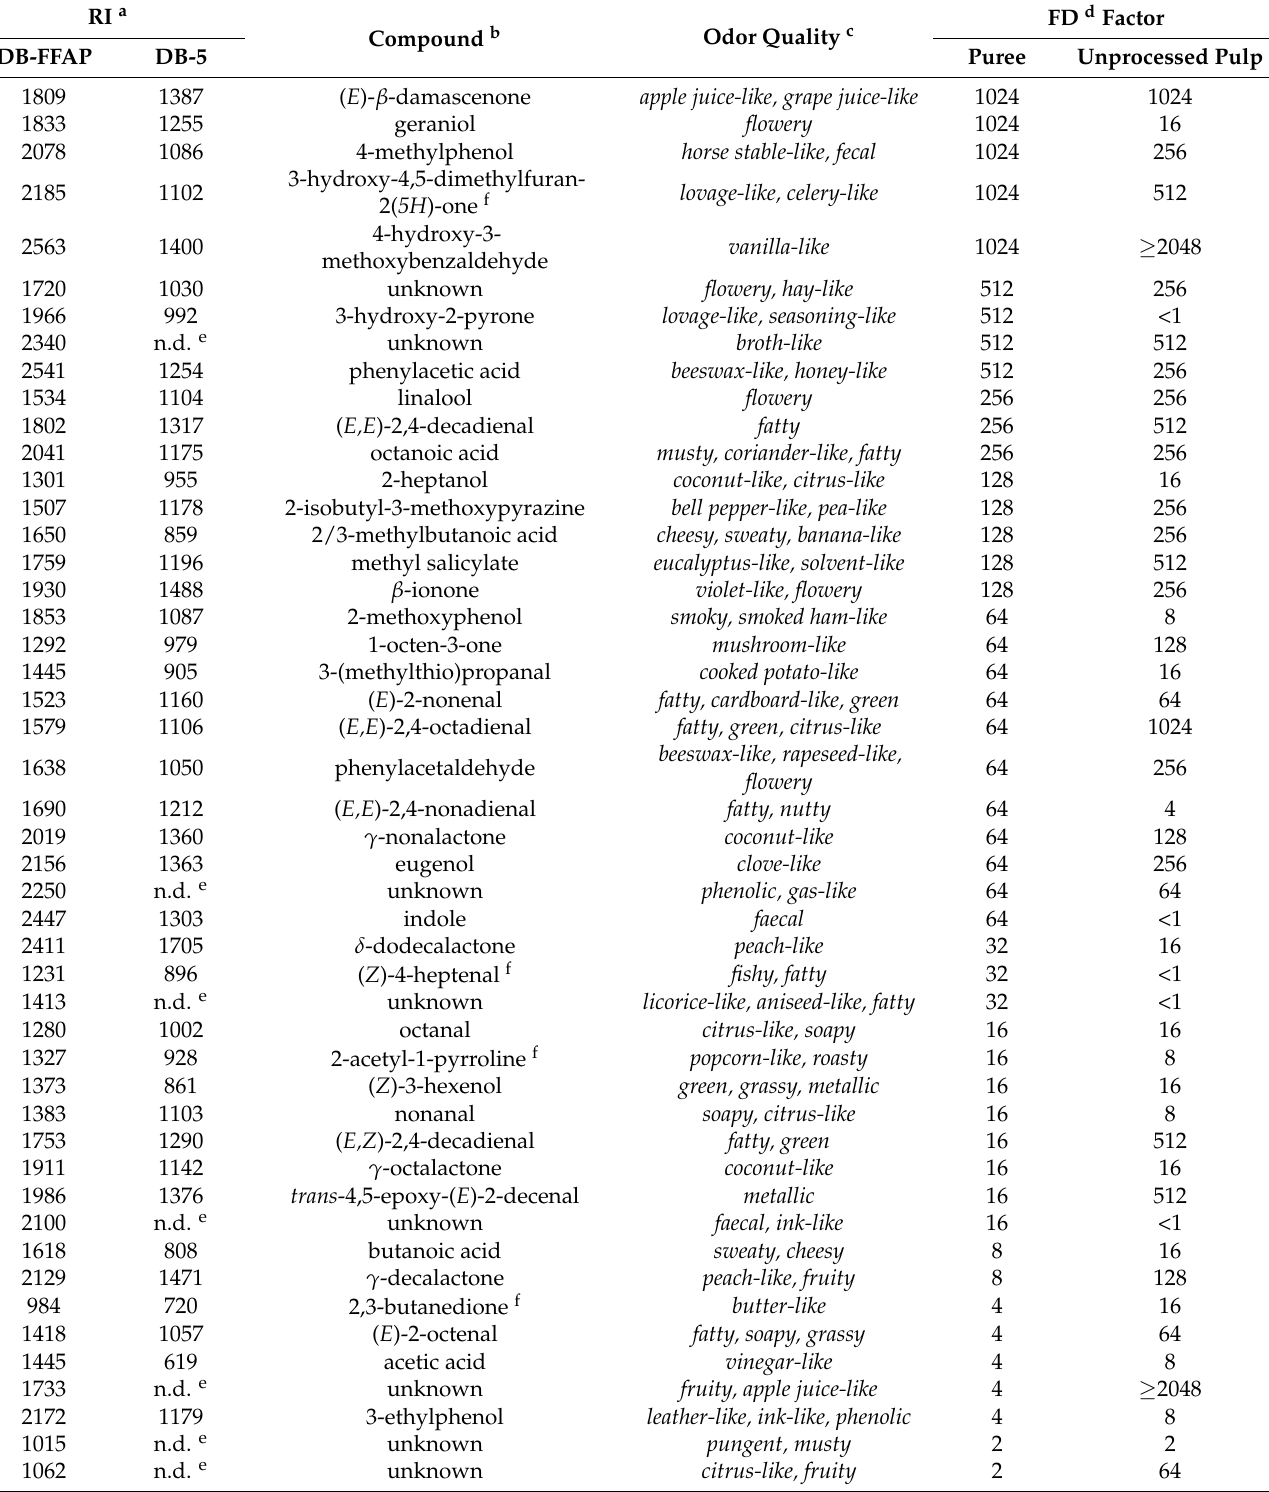
Table 2. Aroma-active compounds and corresponding flavor dilution (FD) factors identified in the distillate obtained from the processed Robusta coffee pulp puree and from the unprocessed Robusta coffee